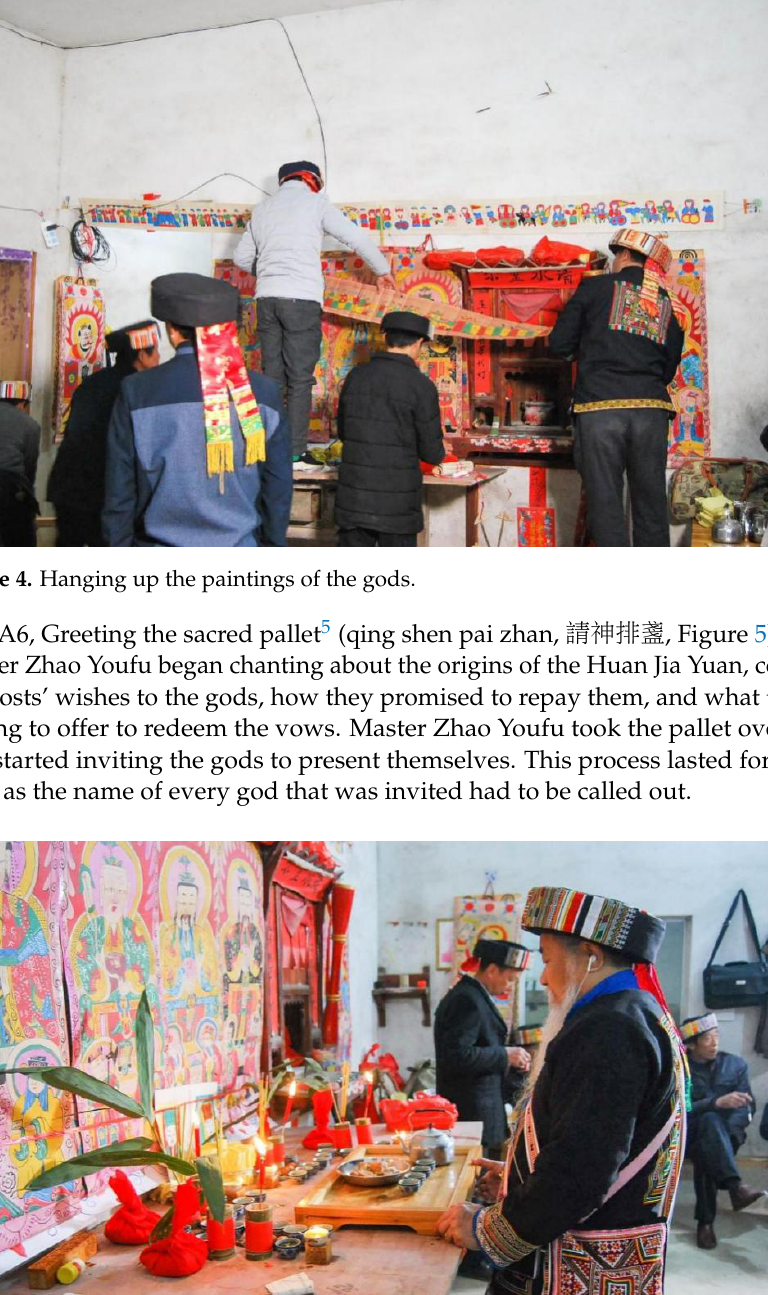
Figure 3. Preliminary toast .